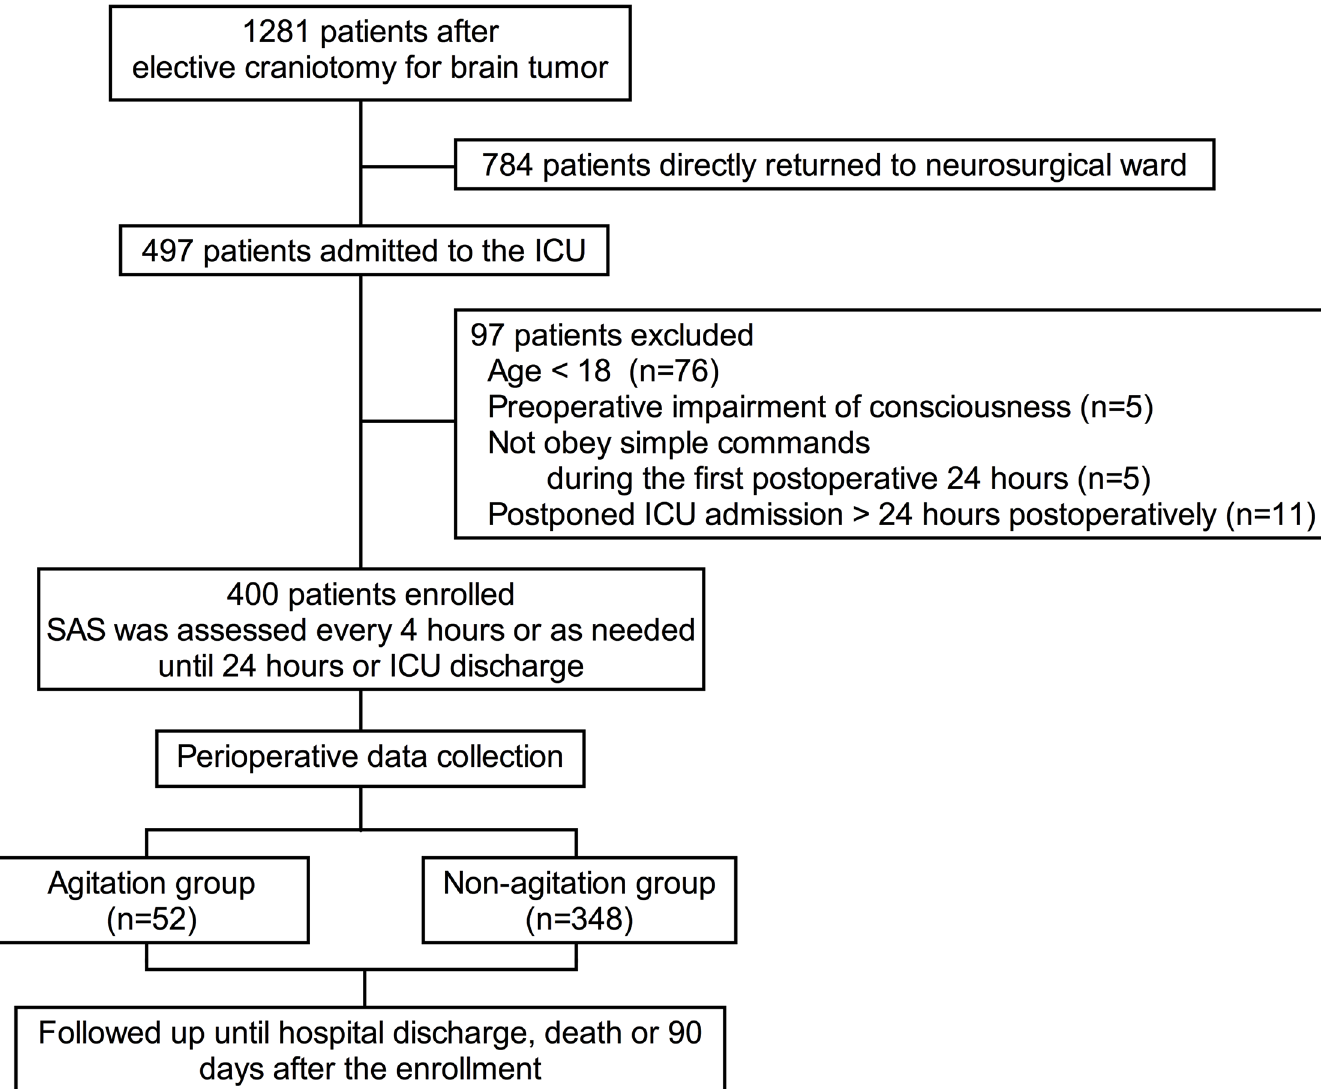
Fig 2. The patients flow diagram. Abbreviations: ICU, intensive care unit; SAS, Sedation-Agitation Scale.